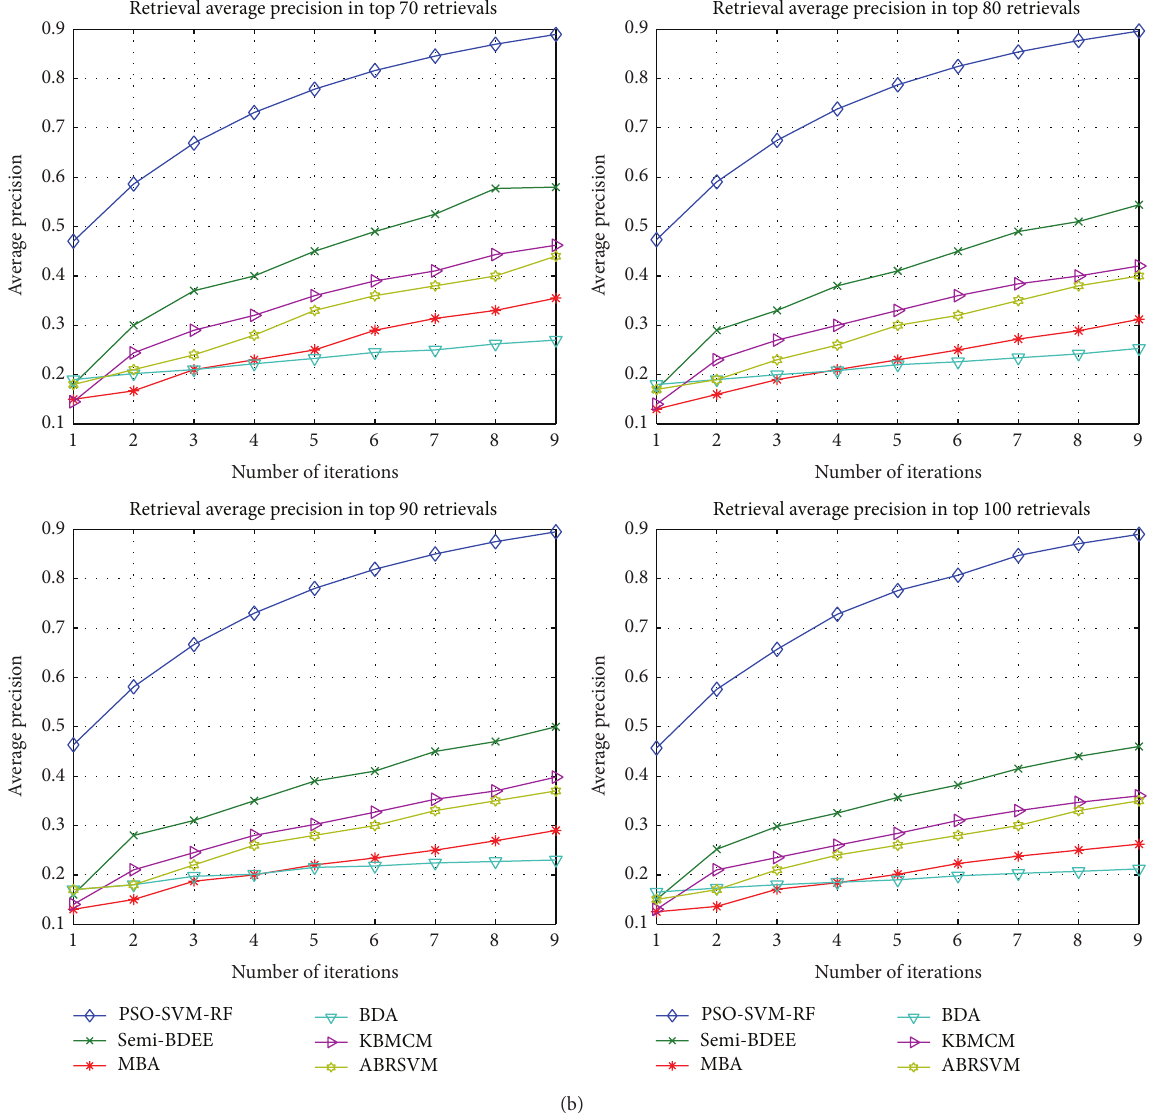
Figure 3: Performance of the proposed PSO-SVM-RF compared against the representative of existing algorithms, that is, semi-BDEE, MBA, BDA, KBMCM, and ABRSVM. All algorithms are evaluated over nine RF iterations.